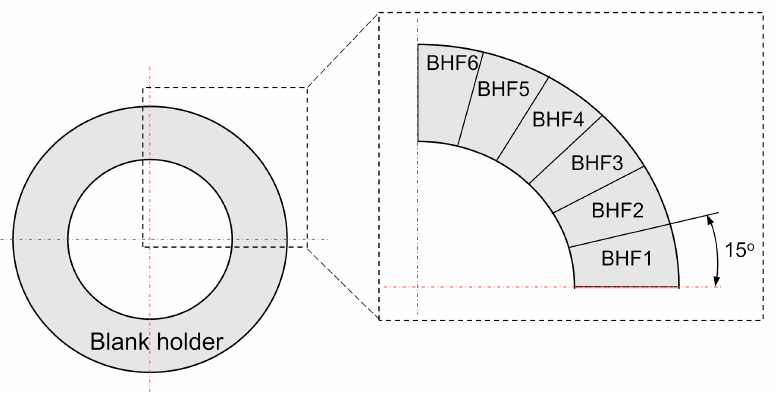
Figure 2. Schematic of the segmental blank holder with an accurate angle of 15° for applying the varying blank holding force (BHF).